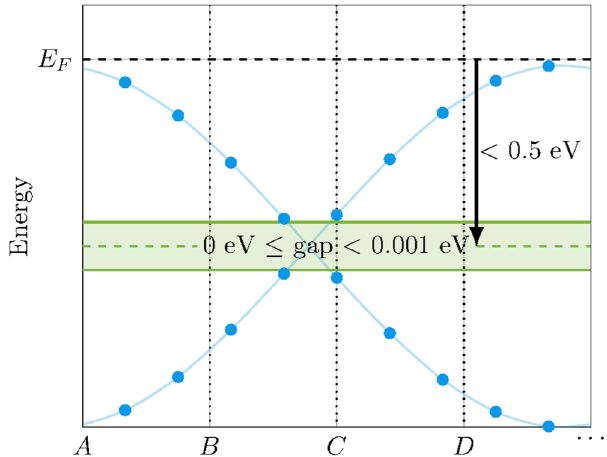
Figure 2. Illustration of the search criteria for isolated Dirac crossings near the Fermi level. The algorithm selected all materials with either zero or tiny direct energy gaps (less than 1 meV) located up to 0.5 eV above the minimum energy of the lowest conductance band or 0.5 eV below the maximum energy of the highest valence band, where no other bands can be found within the corresponding energy range of the gap. The purpose of this gap is to introduce numerical tolerance since the band structure calculations were performed along a discrete